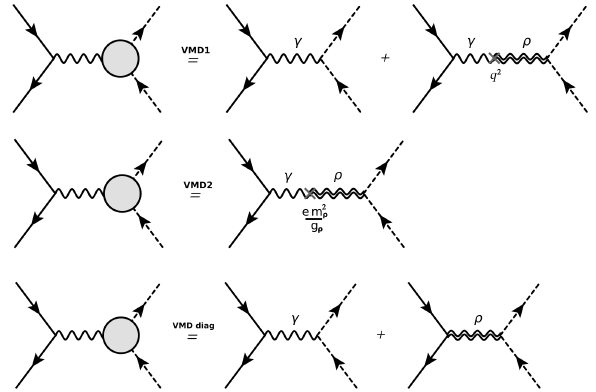
Figure 14 . Pion form factor in the different Vector Meson Dominance